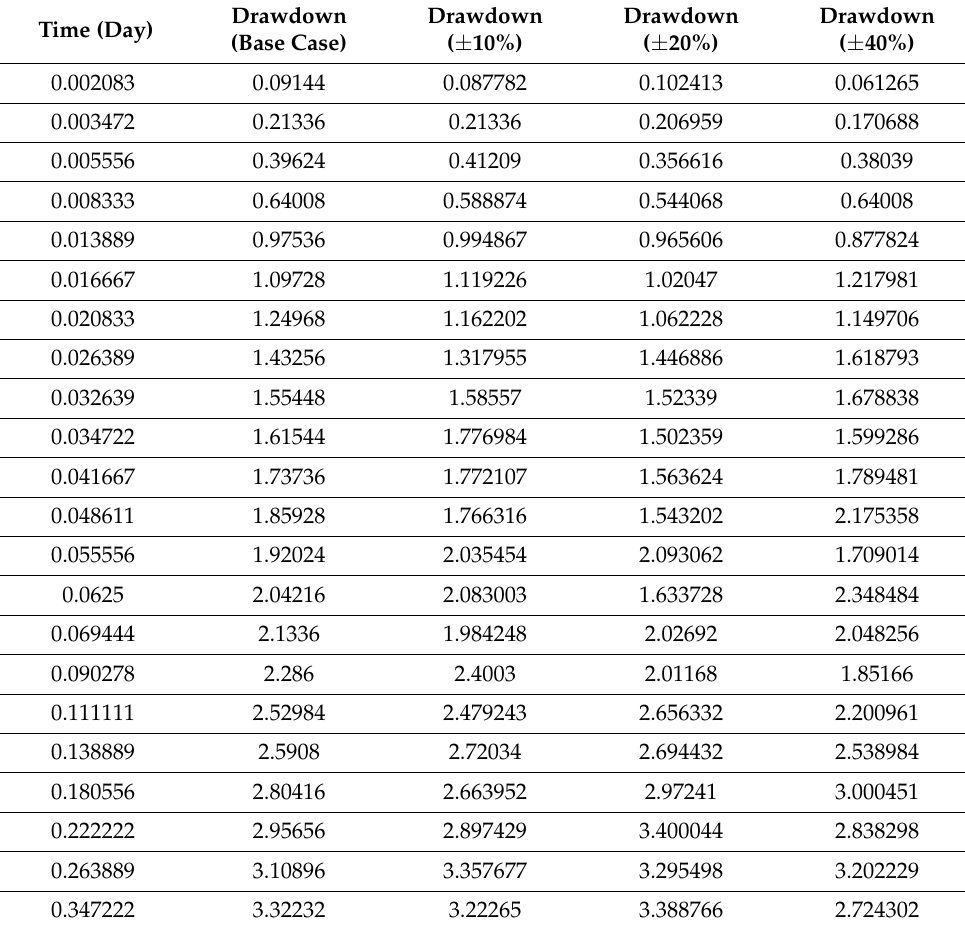
Table A1. Time (day) vs. drawdown (m) data for the perturbed Walton (1962)